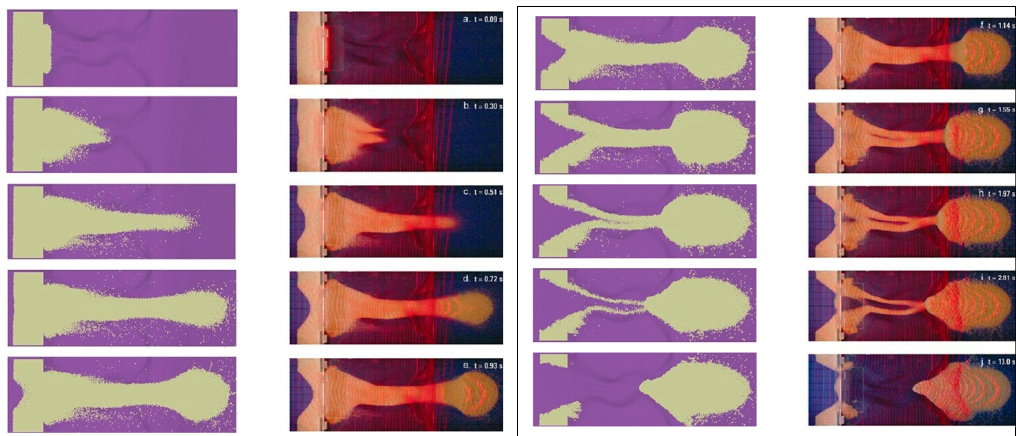
Figure 5. Comparison of between DEM simulation ( left ) and laboratory experiment ( right ) [20]